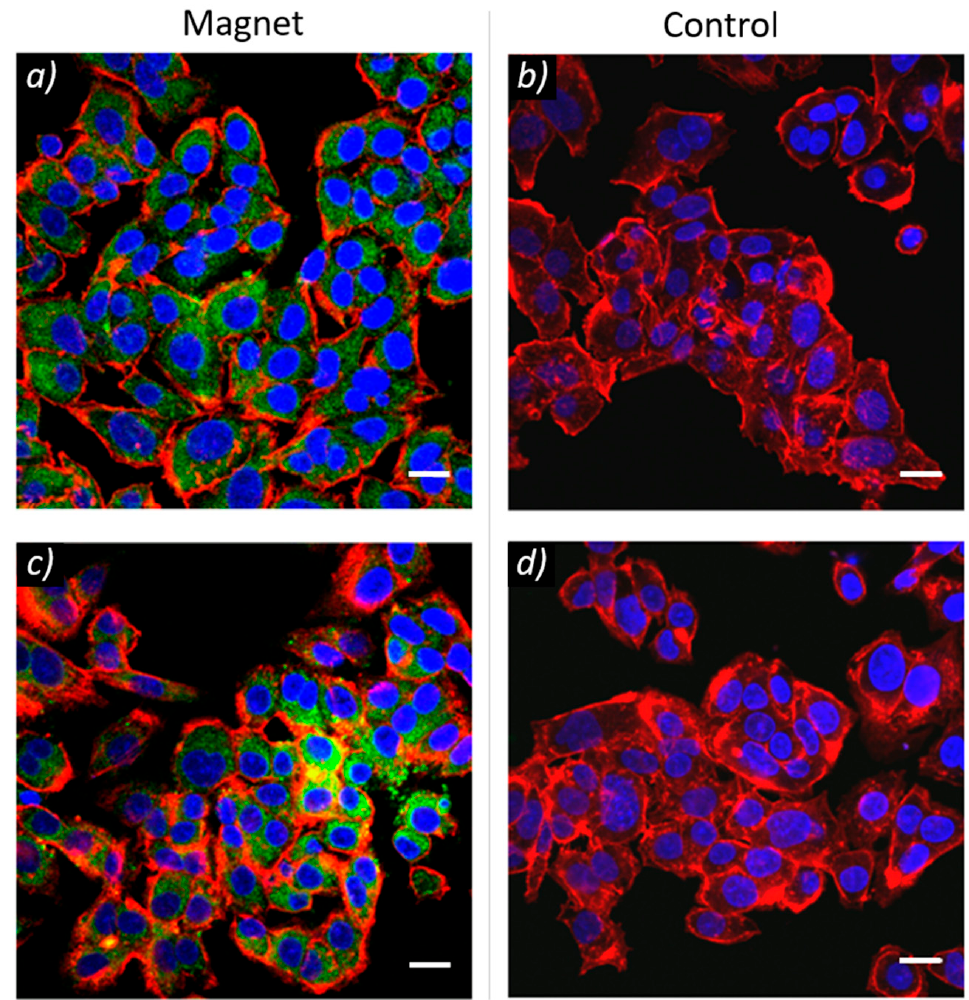
Figure 5. MagLipo magnetic targeting experiments showed selective liposomes cell internalization (in green) with HepG2 cancer cells in correspondence of the edge of the magnet ( a , c ). Conversely, no liposomes were present in the control channel, where no external magnet was placed ( b , d ). f-actin was stained in red, nuclei in blue. All scale bars are 20 µm.